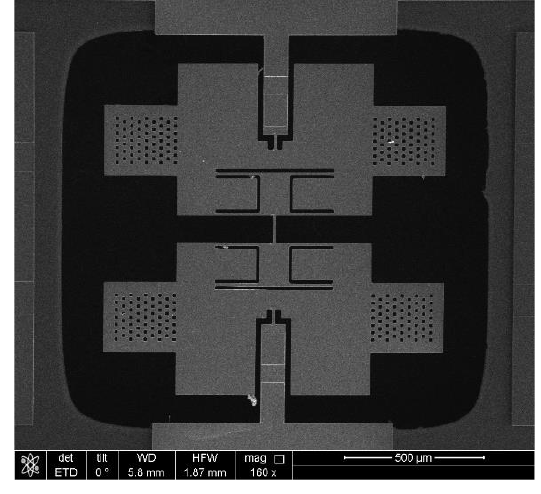
Figure 5. ( A ) The fabrication process of BFVG in 3D wafer-level packaging. ( B ) The device structure of the sensing element.